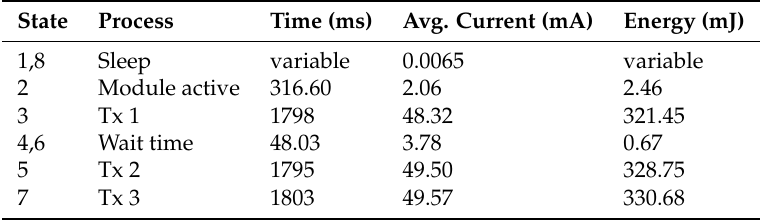
Table 5. Current composition split into different states of operation for